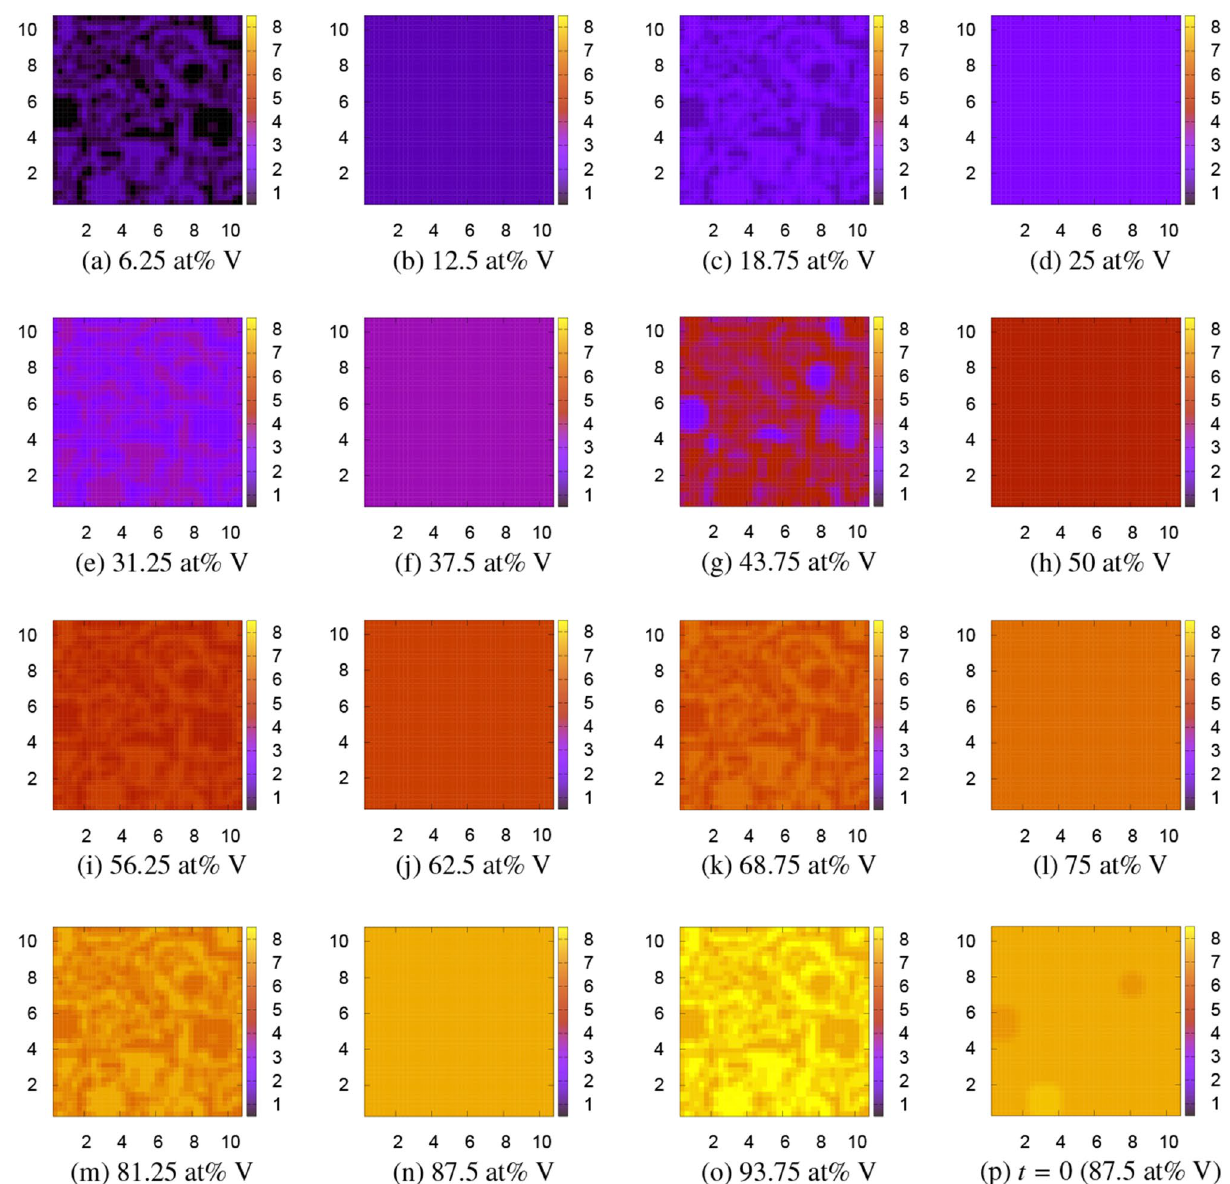
Figure 5. Microstructures of the Ti 8 doubled 8-atom unit cell at 1300 K. The color bar indicates the V concentration φ V The scales in x and y axes can roughly be regarded as the order of μm. The patterns do not change at all at 0 K. (p) is the initial pattern at t